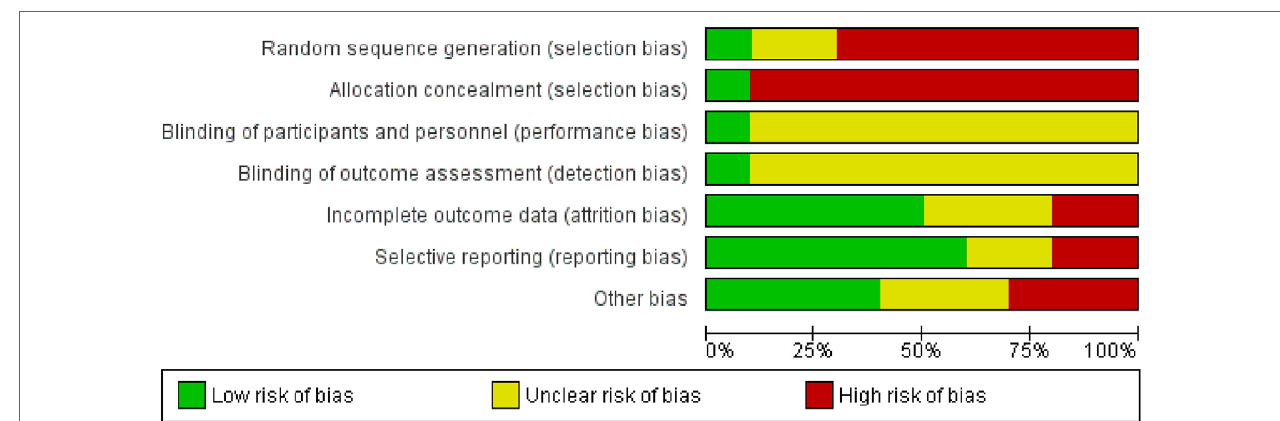
FigURe 3 | Risk of bias graph according to the Cochrane Handbook for Systemtic Review Intervention (52). Authors’ judgements about each risk of bias item presented as percentages across all included studies.